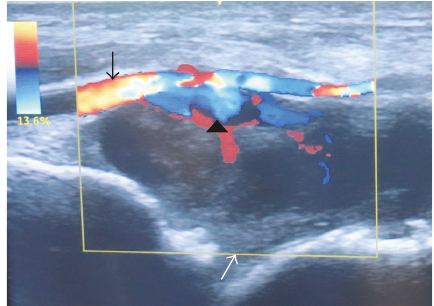
Figure 6: Color and duplex Doppler ultrasonography showing flow through the anterior tibial artery (black arrow) at the anterior ankle joint, with decreased flow through the dorsalis pedis artery, suggest- ing a pseudoaneurysm (white arrow) leaking into the ankle joint (black arrow head). Flow towards and away from the transducer is indicated by red and blue, respectively.